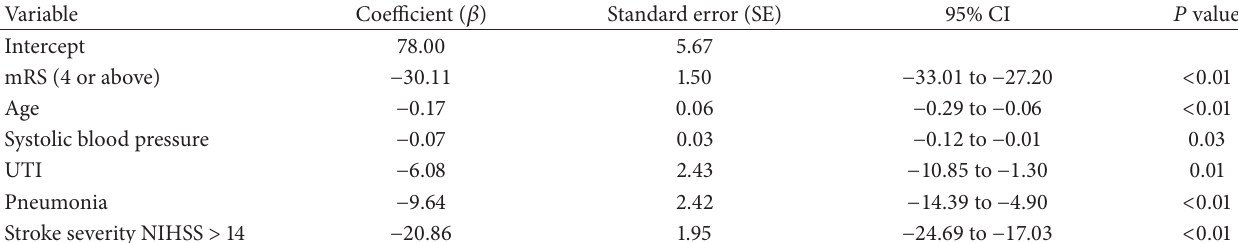
Table 6: Results of multiple linear regression with Barthel score as the